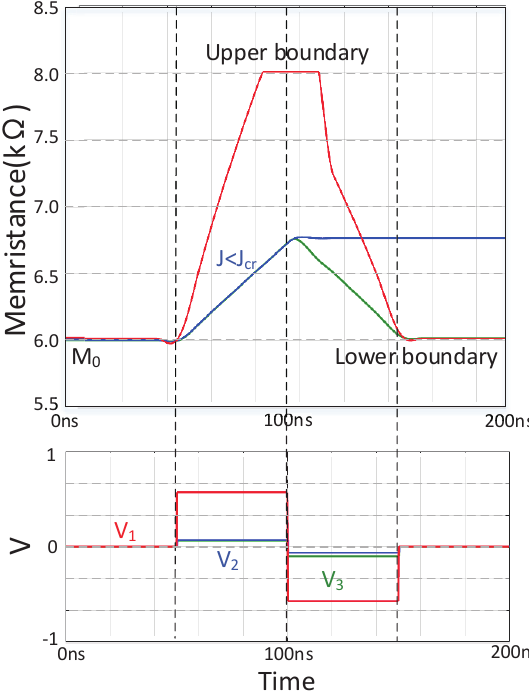
Figure 3. The change rule of the resistance value of the spin memristor model under the action of a voltage source of a fixed